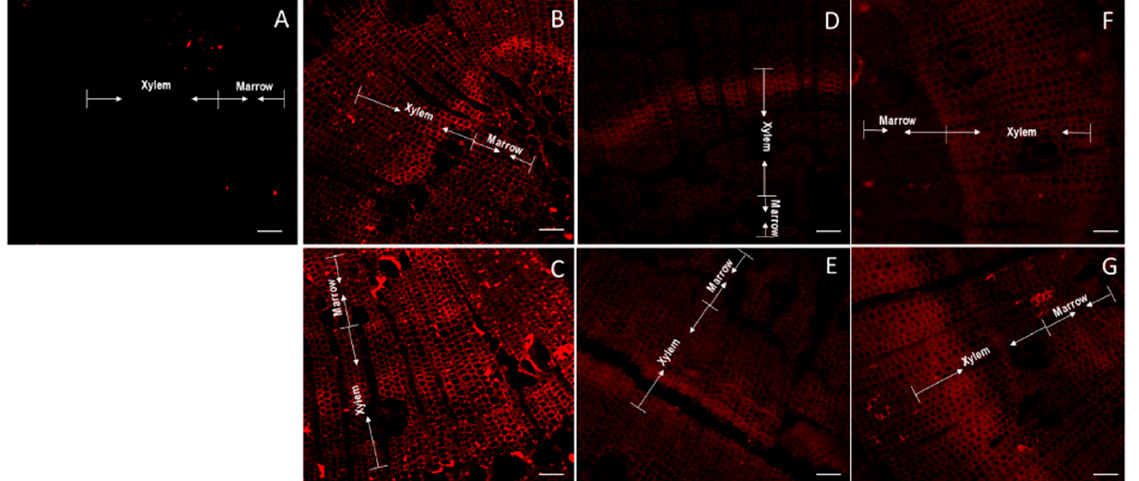
Figure 6. Confocal microscopy of thin sections of one year old radiata pine seedlings incubated with LM6 antibody and Alexa Fluor. Control stem (non-inclined) ( A ). Upper side of inclined stems after 2.5 h ( B ), 10 h ( D ) and 24 h ( F ). Lower side of inclined stems after 2.5 h ( C ), 10 h ( E ) and 24 h ( G ). Arrows indicate the section within the cuts corresponding to marrow, xylem and phloem. Scale of 100 μ m.